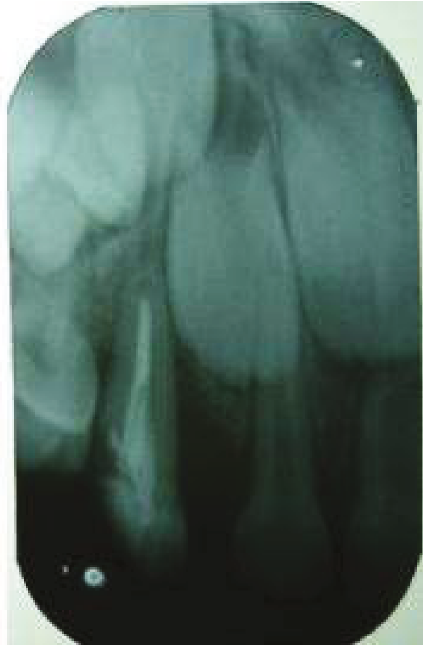
Figure 5: Radiograph taken at 6th-month follow-up.